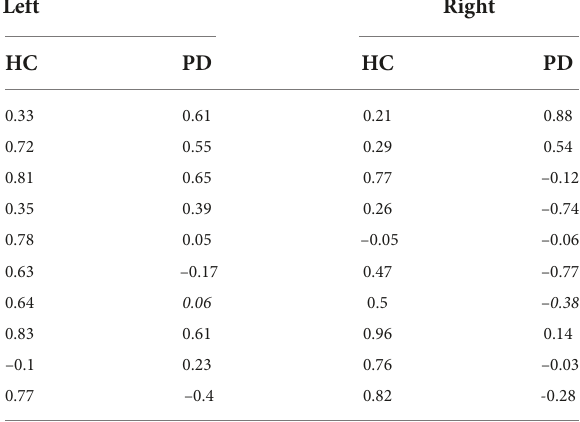
TABLE 5 Correlation between shallowness of the valley and switching time variability, for healthy controls (HC) and PD patients, separated for the two starting locations of the ball.